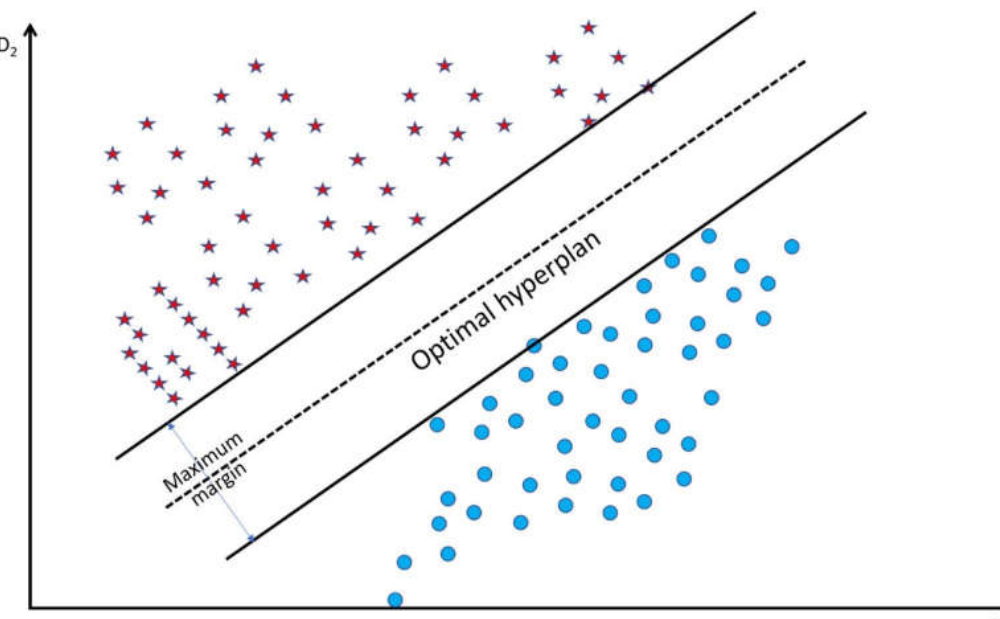
Figure 2. Support vector machine (SVM)-based binary classification.